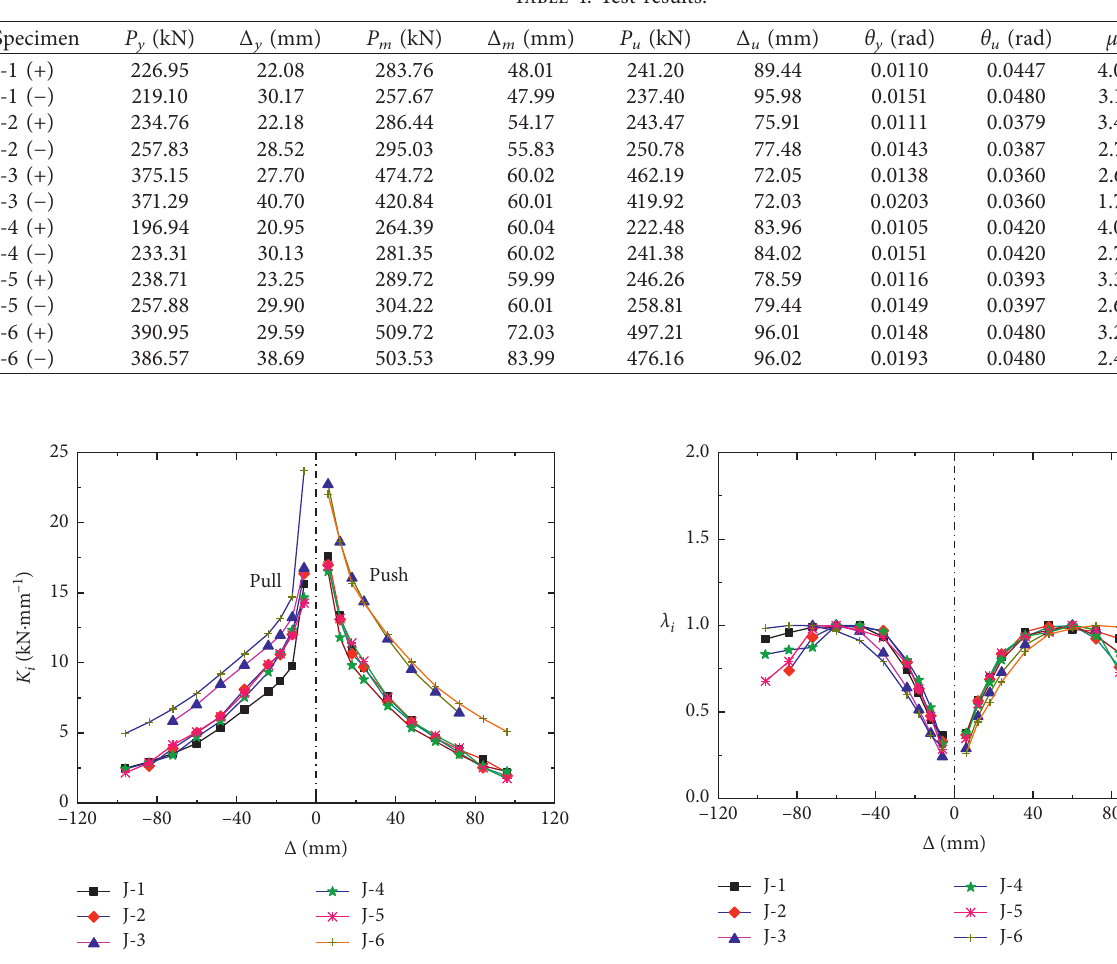
Figure 16: Stiffness degradation curves. Figure 17: Strength degradation